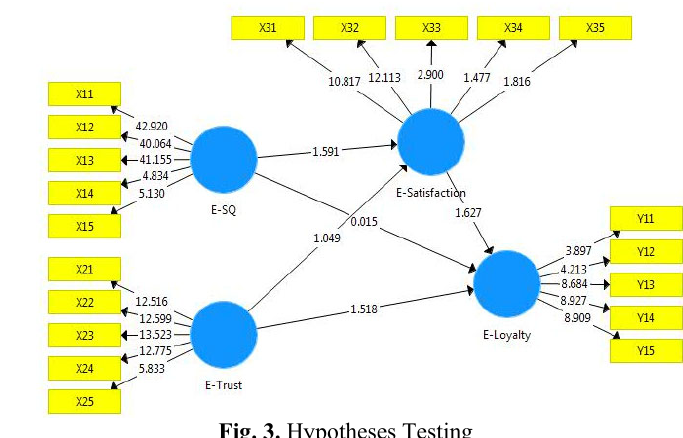
Fig. 3. Hypotheses Testing